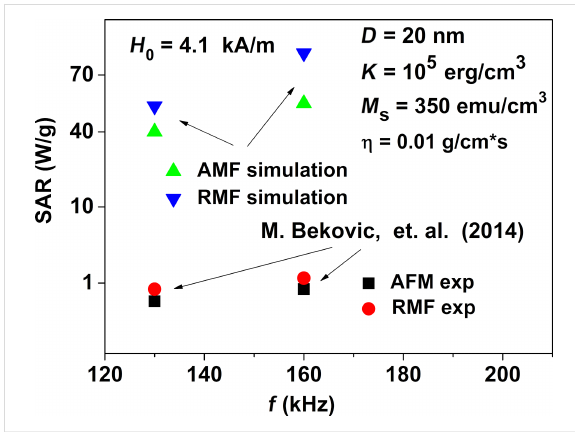
Figure 6: Comparison of the experimentally measured SAR values [41] at frequencies f = 130 and 160 kHz and amplitude H 0 = 4.1 kA/m, with the SAR calculated numerically for a dilute assembly of magnetic nanoparticles in AMFs and RMFs.